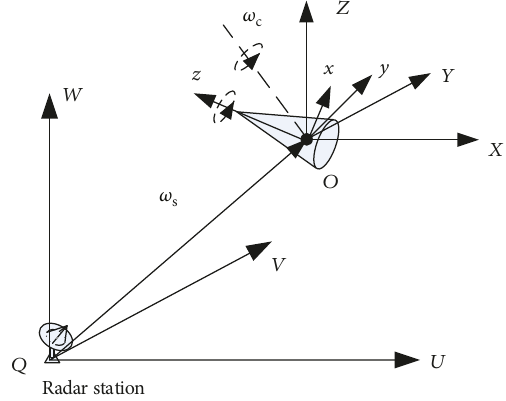
Figure 1: Geometric relationship between the radar and precession